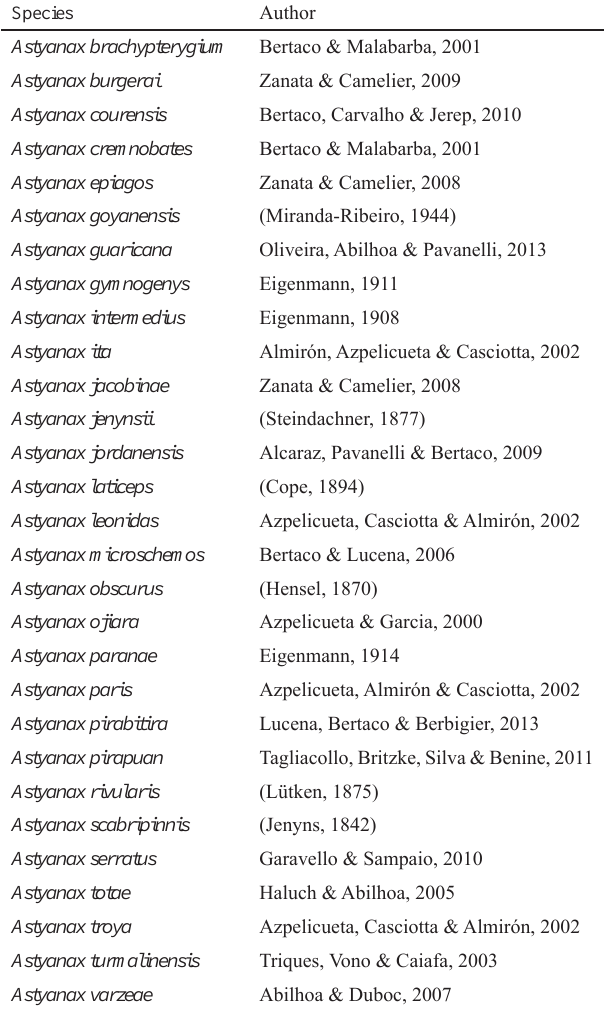
Table 1. List of the species included in the Astyanax scabripinnis species complex sensu Bertaco & Lucena